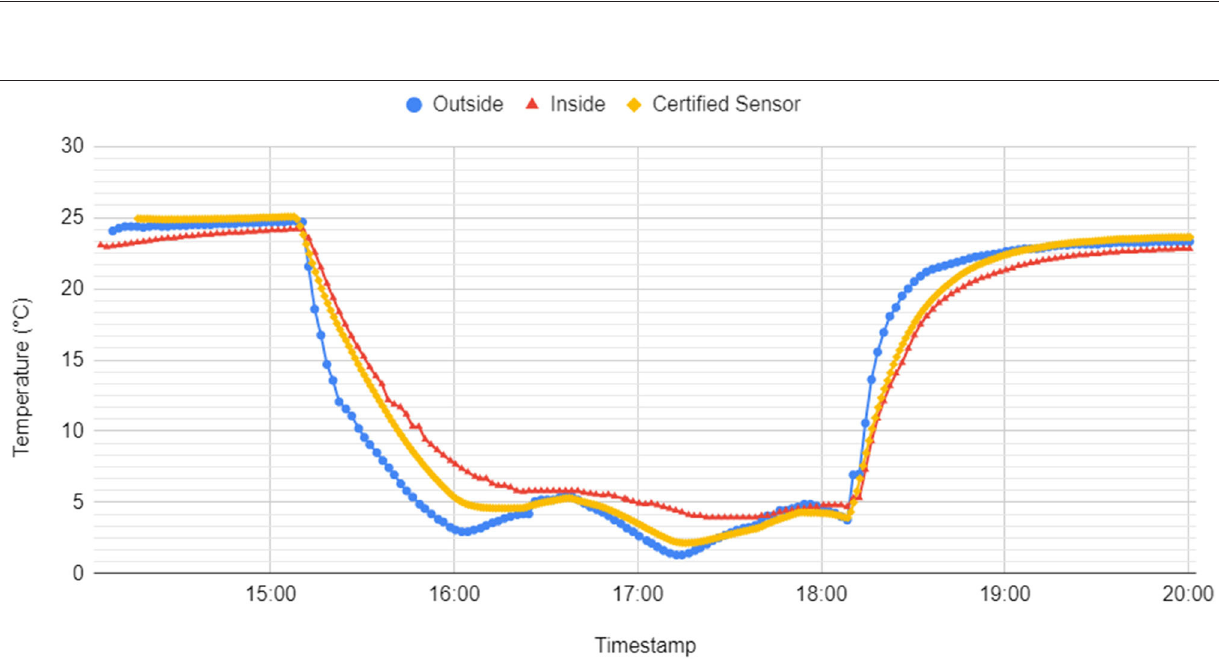
Frontiers in Sustainable Food Systems |